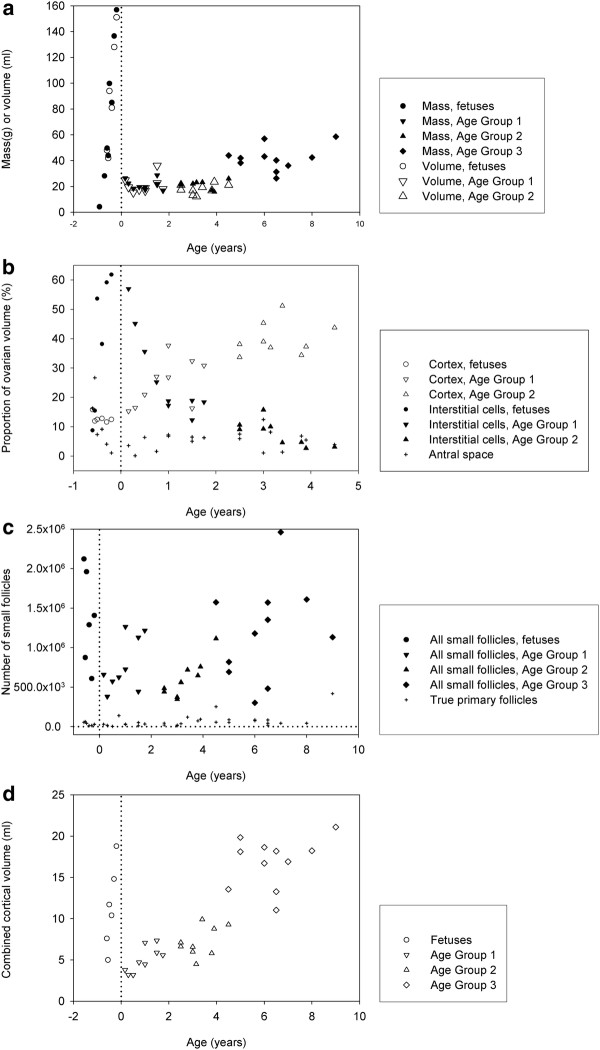
 (a) Combined weights and volumes of both ovaries from African elephant fetuses from mid-gestation onwards and calves up to 9 years of age (volumes were calculated using Cavalieri’s principle). (b). Relative contributions of cortex, interstistial cells and follicular antra to the volumes of the ovaries from African elephant fetuses (from mid-gestation onwards) and calves up to 4.5 years of age (volumes were calculated using Cavalieri’s principle. (c). The number of small follicles in the elephant fetus and prepubertal calf in relation to age. (d). Cortical volume of both ovaries combined of fetal and prepubertal ovaries of African elephants (volumes were calculated using Cavalieri’s principle.